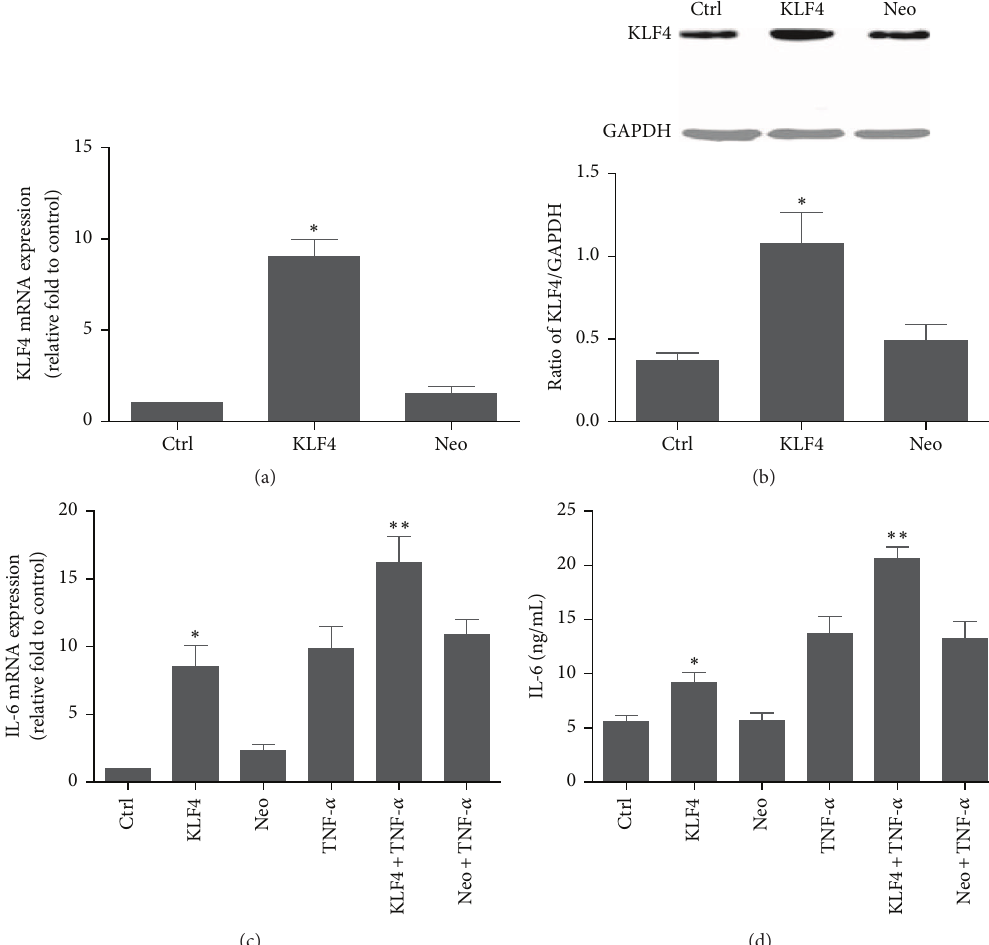
Figure 3: KLF4 overexpression induces IL-6 expression in RA FLSs. RA FLSs were transiently transfected with pcDNA3.1-KLF4 (KLF4) or the pcDNA3.1 empty vector (Neo) and then incubated with TNF- 𝛼 (20ng/mL). Expression of KLF4 was assessed after 3 h by real-time PCR (a) and after 12h by western blotting (b). Expression of IL-6 was assessed after 3h by real-time PCR (c) and ELISA (d). GAPDH as an endogenous control. Data were expressed as mean ± SEM ( 𝑛 = 3 ); ∗ 𝑃 < 0.05 in comparison to the untreated cells (Ctrl); ∗∗ 𝑃 < 0.05 in comparison to the TNF- 𝛼